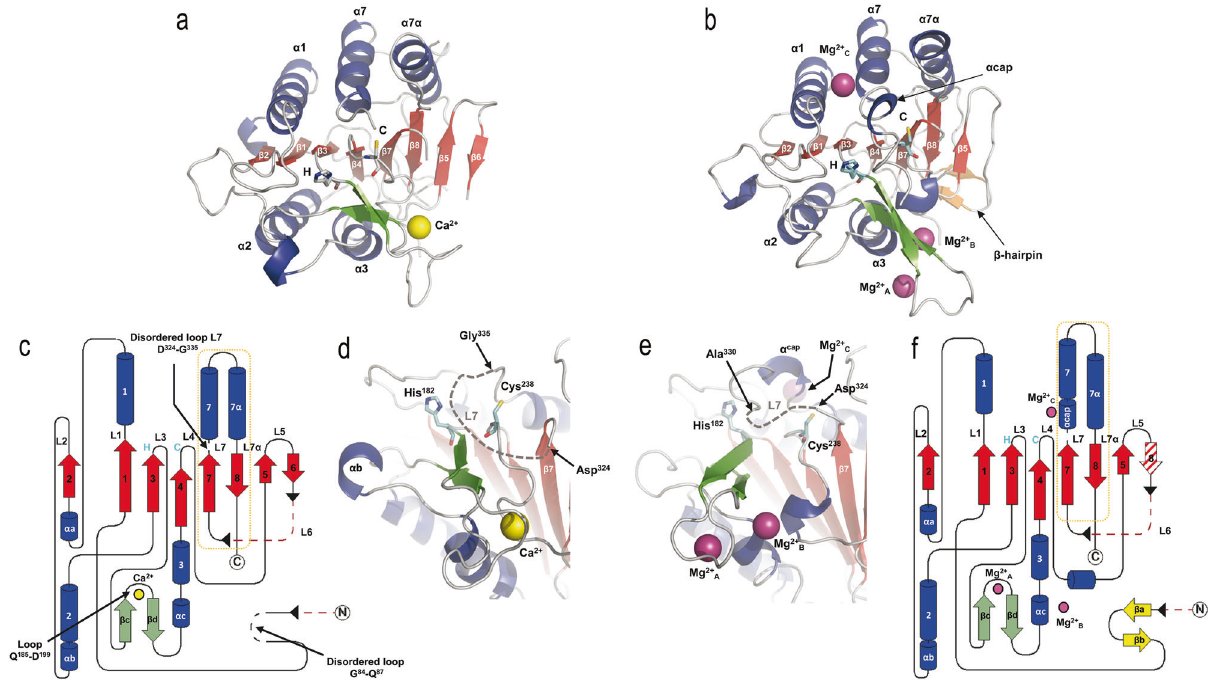
Fig. 3 Overall structure organization of Cg MCA-I. Three-dimensional structures of Cg MCA-I Ca and Cg MCA-I Mg monomers, respectively, in complex with ( a ) Ca 2 + ( yellow sphere) or ( b ) Mg 2 + ( purple spheres). α -Helices ( blue ) and β -strands ( red ), with the numbering of the secondary structure elements shown in white and black , respectively ( a ). The three Mg 2 + ions present in Cg MCA-I Mg are named Mg 2 + A , Mg 2 + B , and Mg 2 + C ( b ). Catalytic residues are highlighted as stick presentations by H (His 182 ) and C (Cys 238 ) and colored in cyan . Topological representation of Cg MCA-I Ca ( c ) and Cg MCA-I Mg ( f ). Disordered parts of the proteins are shown in black dotted lines and missing parts of the protein due to the maturation process are shown in red dotted lines ( c , f ). Cleavage sites are indicated by black arrow heads and the p10 subunits are framed by an orange dotted line ( c , f ). Loops numbering (L1 to L7/L7 α ) are indicated ( c , f ). Catalytic site organization of Cg MCA-I Ca ( d ) and Cg MCA-I Mg ( e ), showing the position of the two catalytic residues (His 182 and Cys 238 ) respective to the cations binding sites and the disordered L7 loop, for which the disordered part is indicated by gray dotted